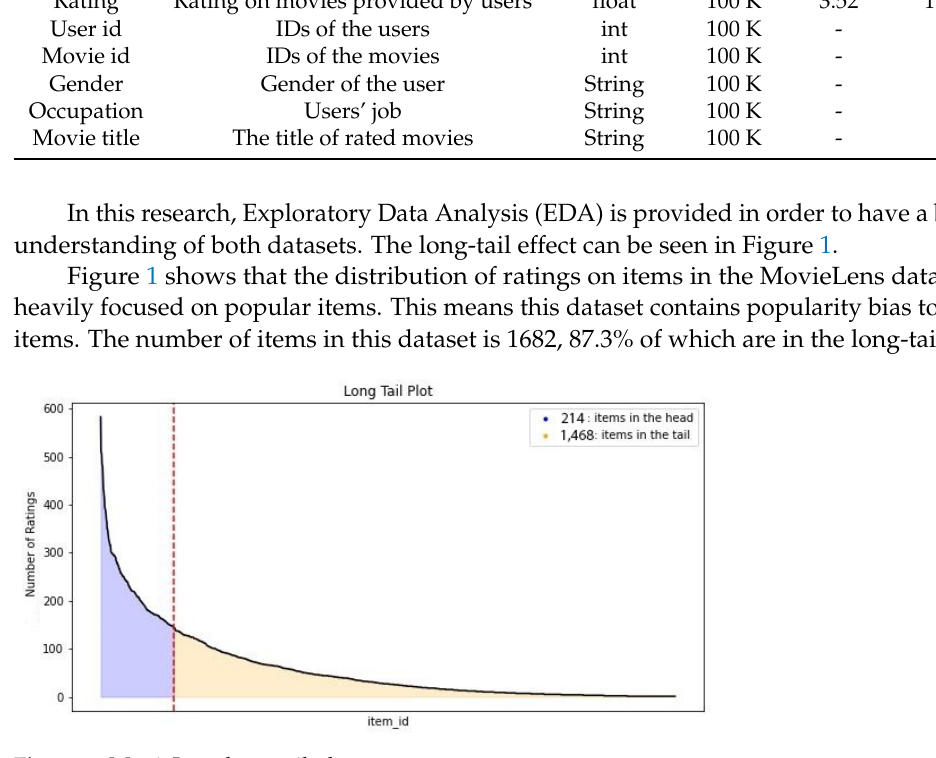
Figure 1. MovieLens long-tail plot.